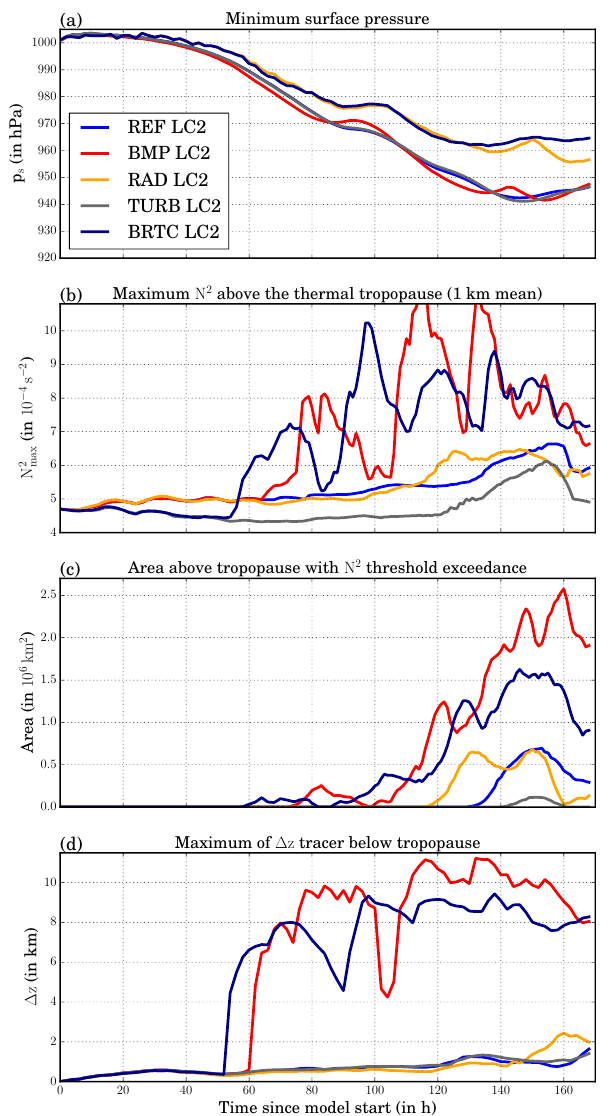
Figure 15. Temporal evolution over the entire simulated life cycles of (a) the minimum surface pressure p s (in hPa), (b) the maximum static stability N 2 max (in 10 − 4 s − 2 ) above the thermal tropopause, (c) the area A 5 . 5 (in 10 6 km 2 ) of N 2 threshold exceedance above the thermal tropopause (with a threshold of N 2 = 5 . 5 × 10 − 4 s − 2 ), and (d) the maximum of the (cid:49)z tracer (in km) in a 500m thick layer below the thermal tropopause. The colored lines indicate the following simulations: REF LC2 (blue), BMP LC2 (red), RAD LC2 (orange), TURB LC2 (gray), and BRTC LC2 (dark